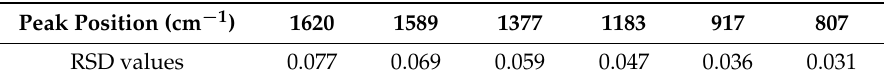
Figure 7. ( A ) Uniformity of SERS spectra of CVs collected on the randomly selected 50 spots of the whole substrate formed by seed I activation and 30 min of soaking, ( B ) the intensities of the main vibrations at 1620 cm − 1 calculated according to the SERS spectra shown in ( A ). Table 2. RSD values for the major peaks of the SERS spectra for the substrate obtained with 30 min of